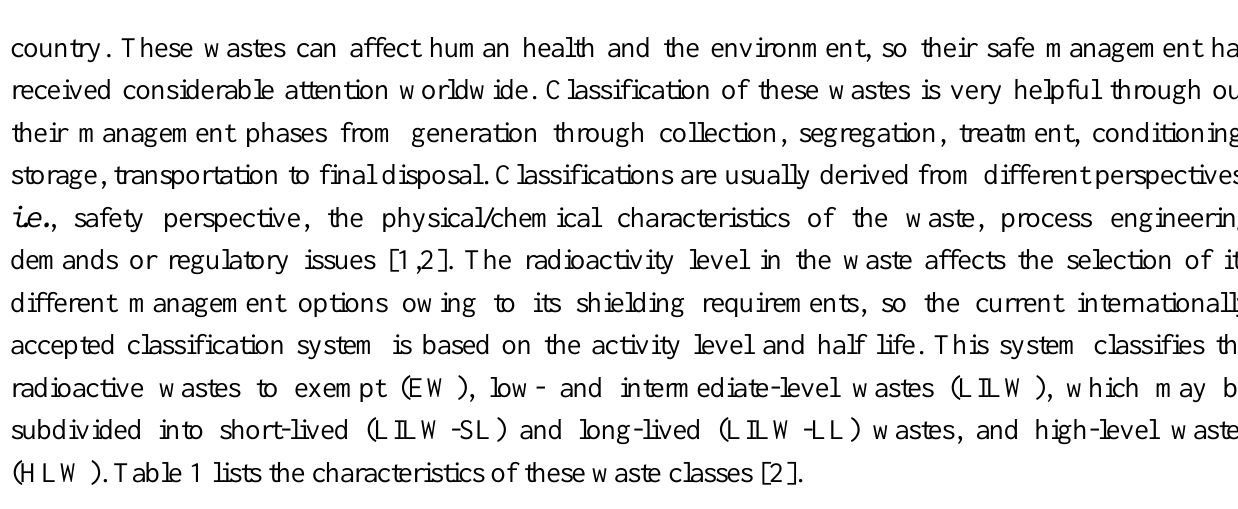
Table 1. Radioactive waste classification